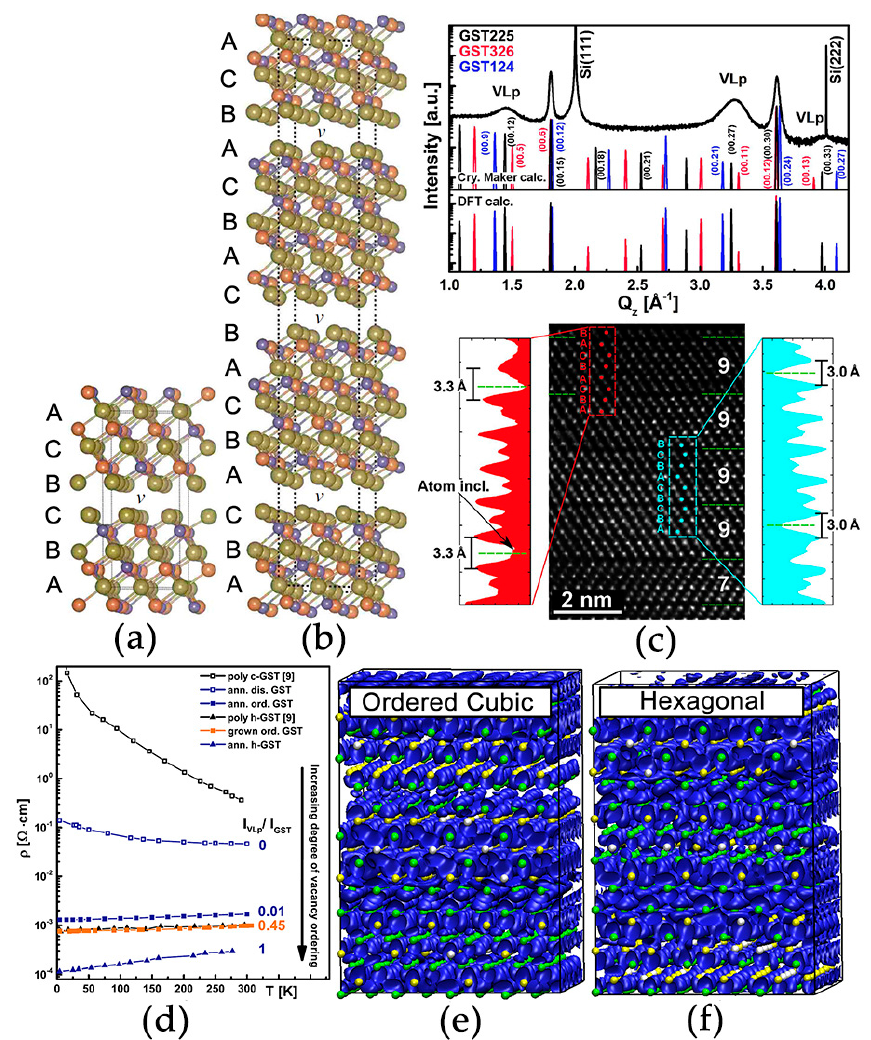
Figure 8. ( a , b ) The atomic structure of hexagonal and ordered cubic Ge 2 Sb 2 Te 5 . The stacking sequence of Te layers is labelled with A, B and C; ( c ) The XRD curve and HAADF-STEM image of ordered cubic Ge 2 Sb 2 Te 5 grown by MBE method. “Vacancy layers” (VLs) appear every 7–9 atomic layers, marked by dashed green lines. The cubic and hexagonal stacking coexists in this MBE grown sample, boxed by red and cyan dashed lines; ( d ) Resistivity as a function of temperature for epitaxial and sputtered GST samples. Empty and filled squares denote the disordered rocksalt phase and ordered cubic phase, while triangles denote the hexagonal phase; ( e , f ) Are snapshots of the HOMO state of the ordered cubic and hexagonal GST. Chemical disorder Ge/Sb on the cation-like layers is included for both models. Adapted with permission from References [12,15,71,93] © 2008 American Physical Society; 2011, 2012, 2016 Nature Publishing Group.